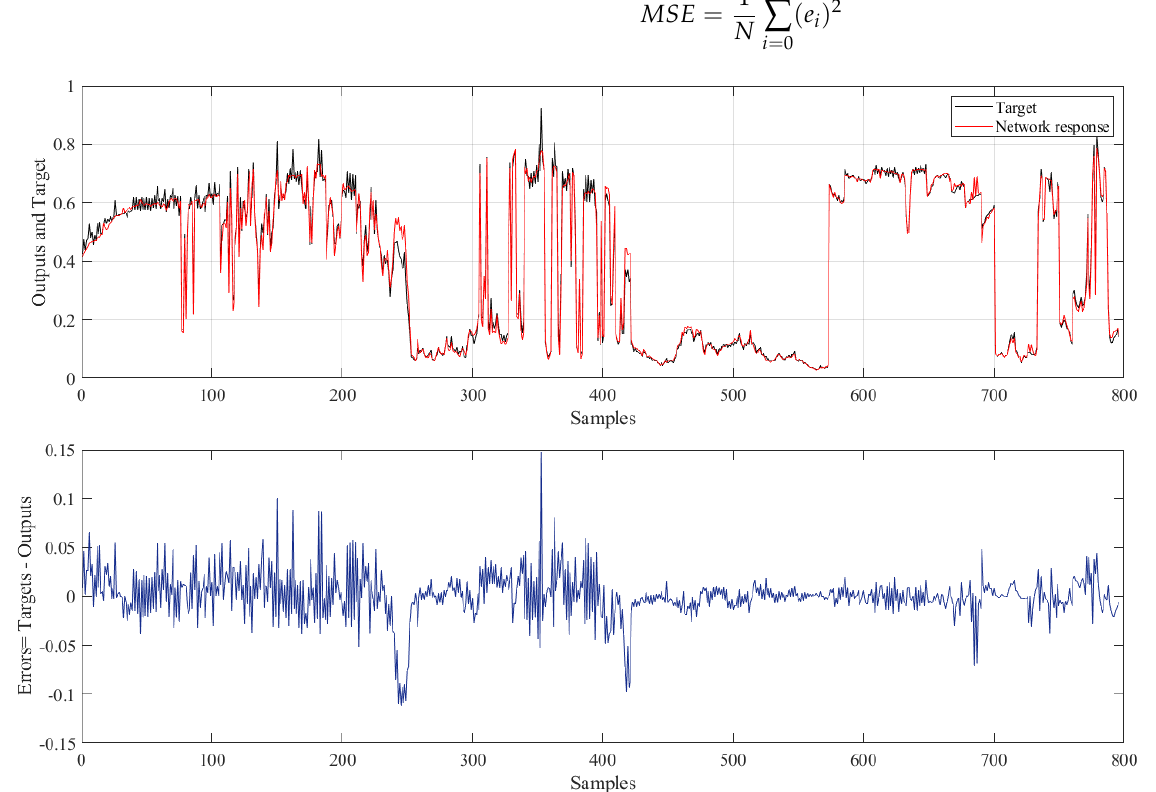
Figure 10. Predicted outputs